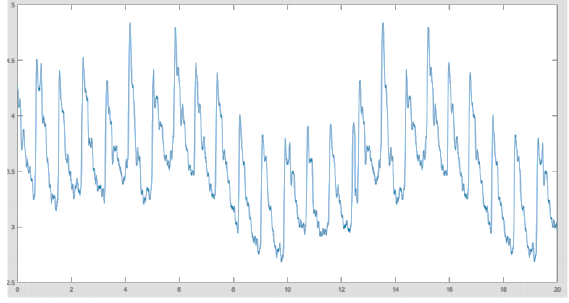
Figure 7. Raw data measurement performed with an improved sensor, before filtering.